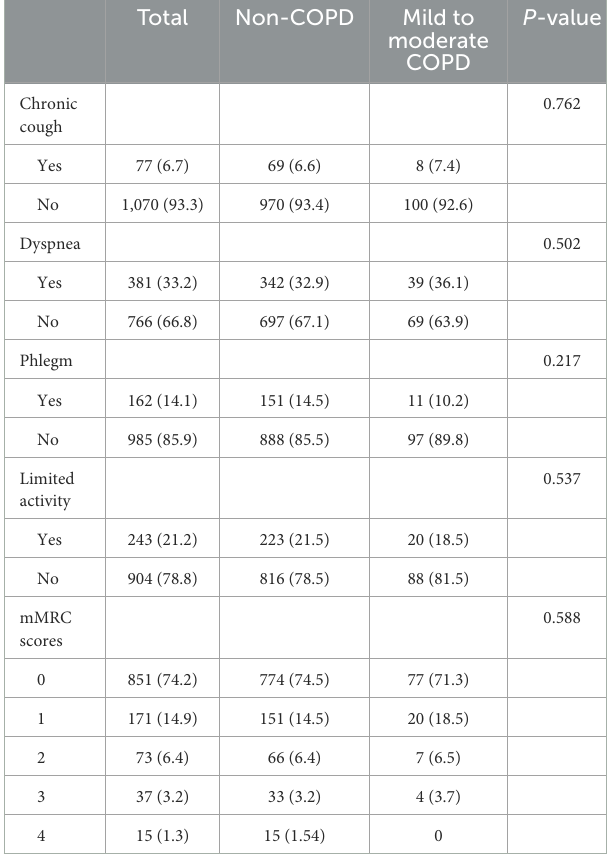
TABLE 1 Demographic characteristics of 1,147 participants with/without COPD.